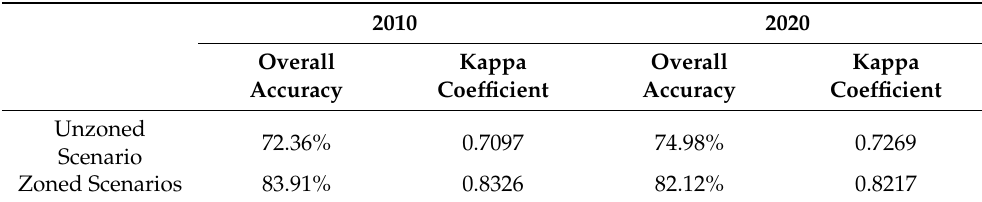
Table 6. Comparison of overall accuracies and Kappa coefficients for partitioned and unparti- tioned scenarios.